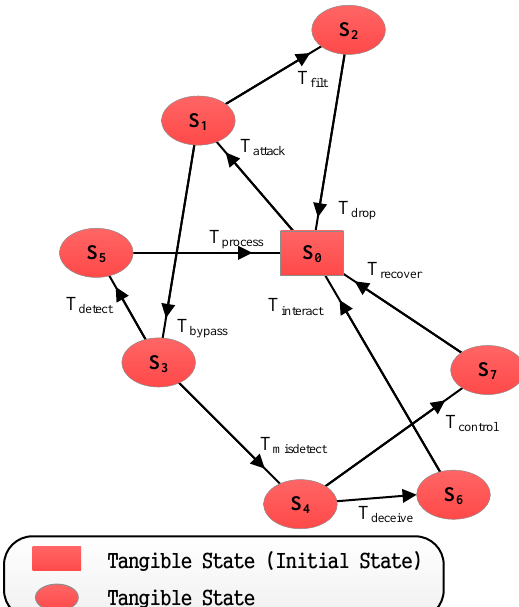
Figure 15. The reachable graph for Scenario III.